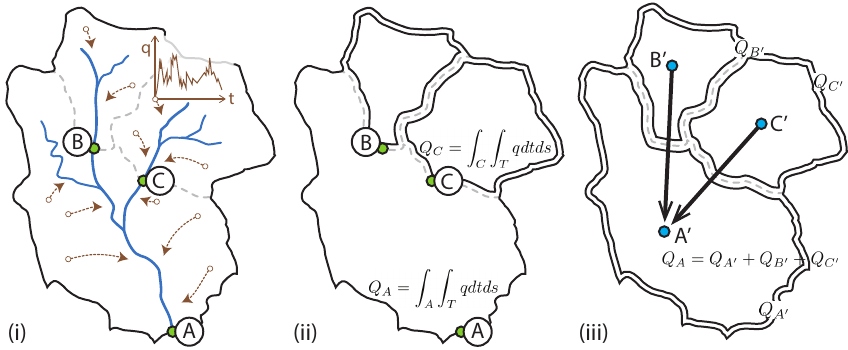
Figure 1. Conceptual flow propagation model. (i) Runoff is generated continuously by a spatially distributed point process and drained to the stream network. (ii) When monitored by stream gauges, runoff is spatially integrated over the corresponding catchment and temporally averaged at the chosen observation frequency (e.g., daily streamflow). (iii) The model conceptualizes the catchments as isolated drainage areas (IDA) (A (cid:48) , B (cid:48) , and C (cid:48) ) representing the local runoff contribution to each gauge. The flow actually measured at each gauge is the sum of the upstream